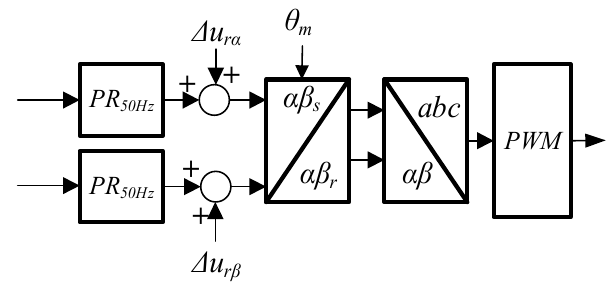
Figure 6. Decoupling and feedforward implementation in DPC of DFIG.